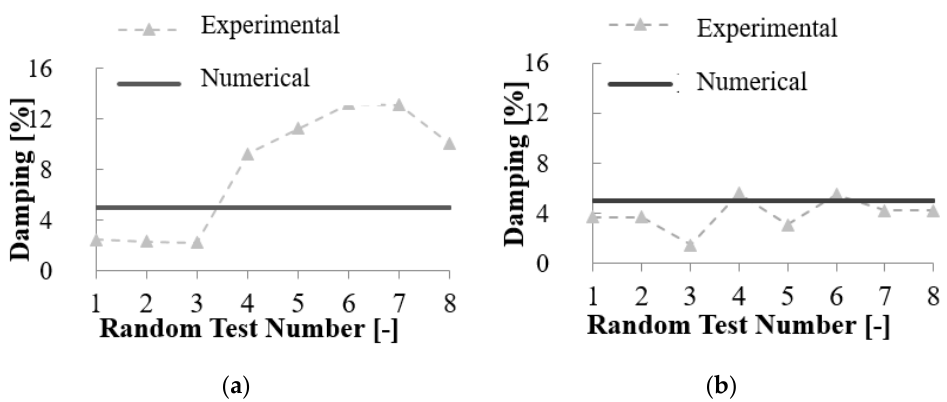
Figure 5. Experimental damping range for ( a ) Type 1 and ( b ) Type 2 mock-ups and Rayleigh damping value selected for the model.